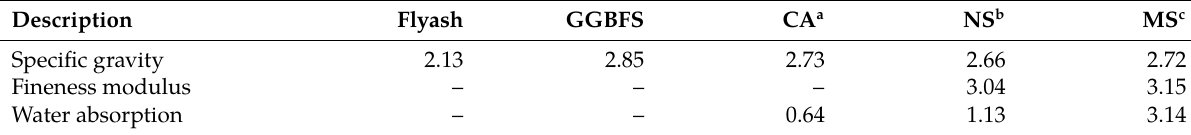
Table 3: Materials physical properties.